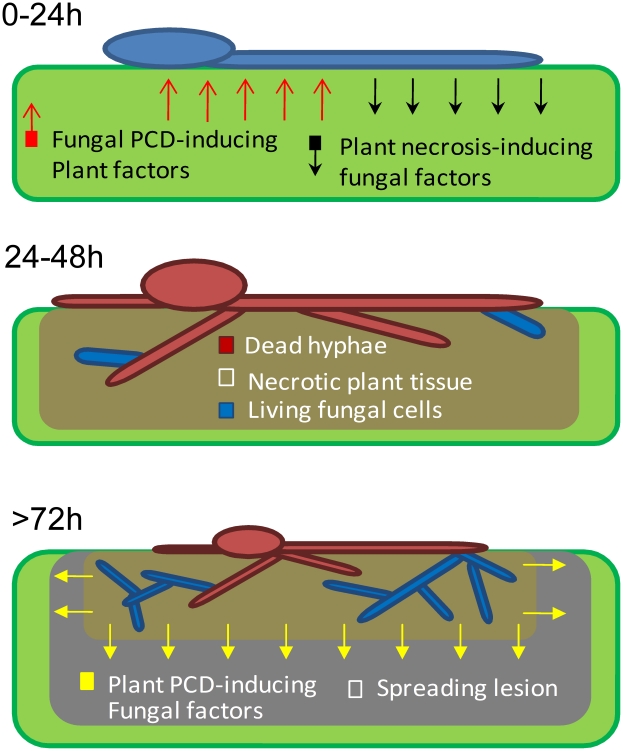
A model showing the role of PCD in early events of B. cinerea infection.0–24: Following landing on the host, conidia germinate and start secreting necrosis-inducing factors. 24–48: Anti-fungal plant metabolites trigger PCD in developing hyphae, which kill most of the fungal cells. Anti-apoptotic machinery (mediated by BcBir1) prevents complete elimination of the fungus at this stage. >72: Viable fungal cells retained within the necrotized plant tissue are protected from the host toxic molecules. These cells give rise to new hyphae which secrete molecules that induce PCD in surrounding plant tissue and promote lesion spreading.